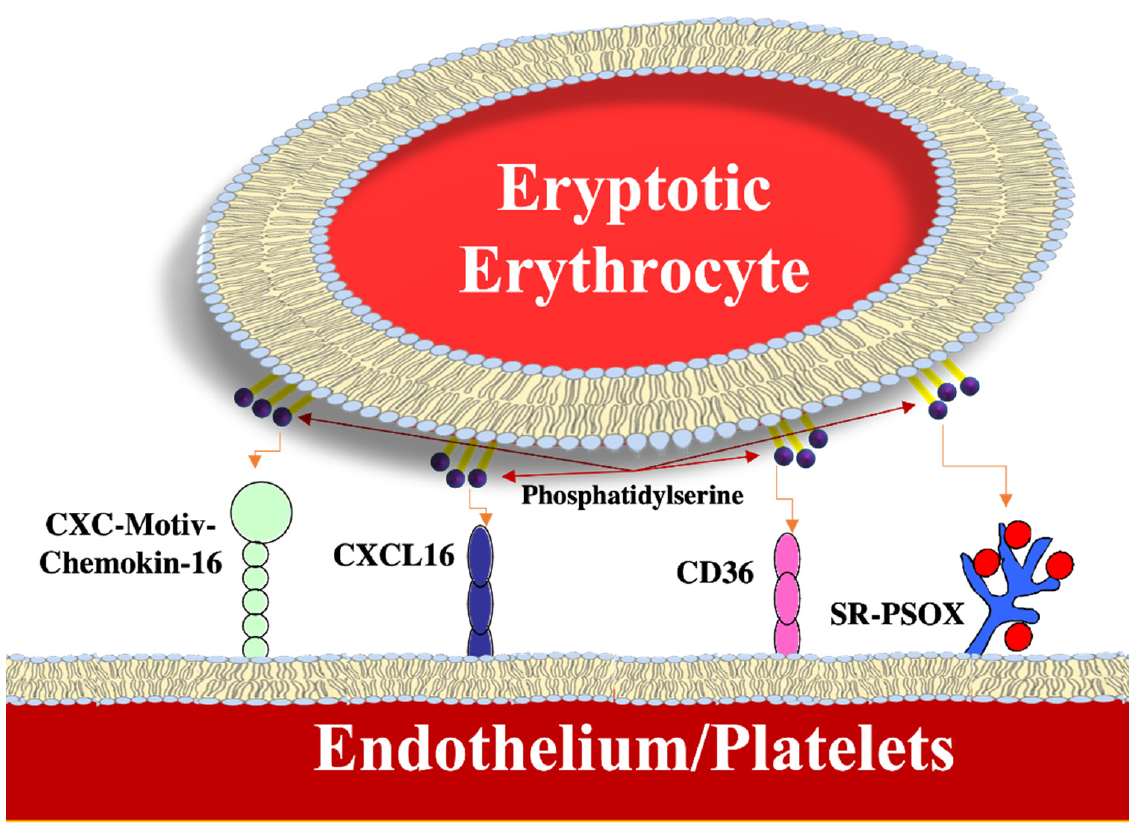
Figure 3. Exemplification of the adhesion of RBC to blood vessel or platelets.